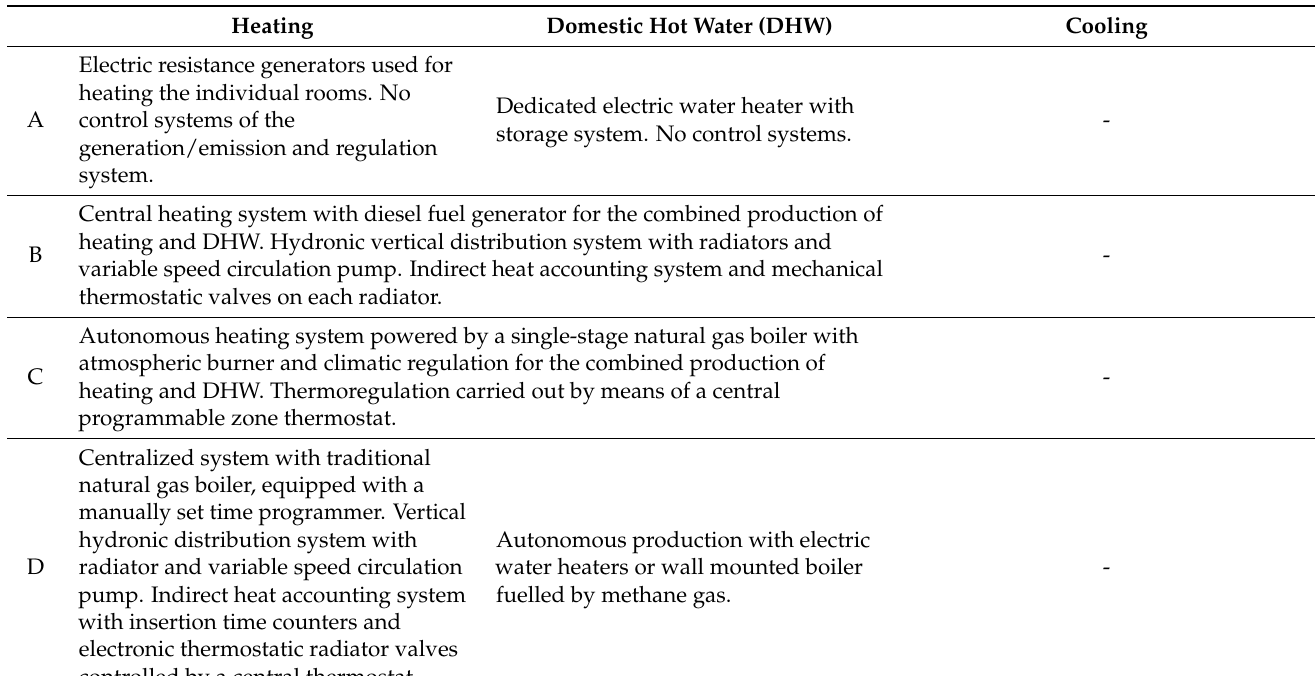
Table 3. Main systems characteristics of the smart building typologies (base